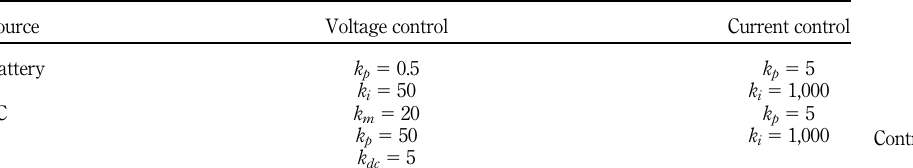
Table 2. Controller parameters